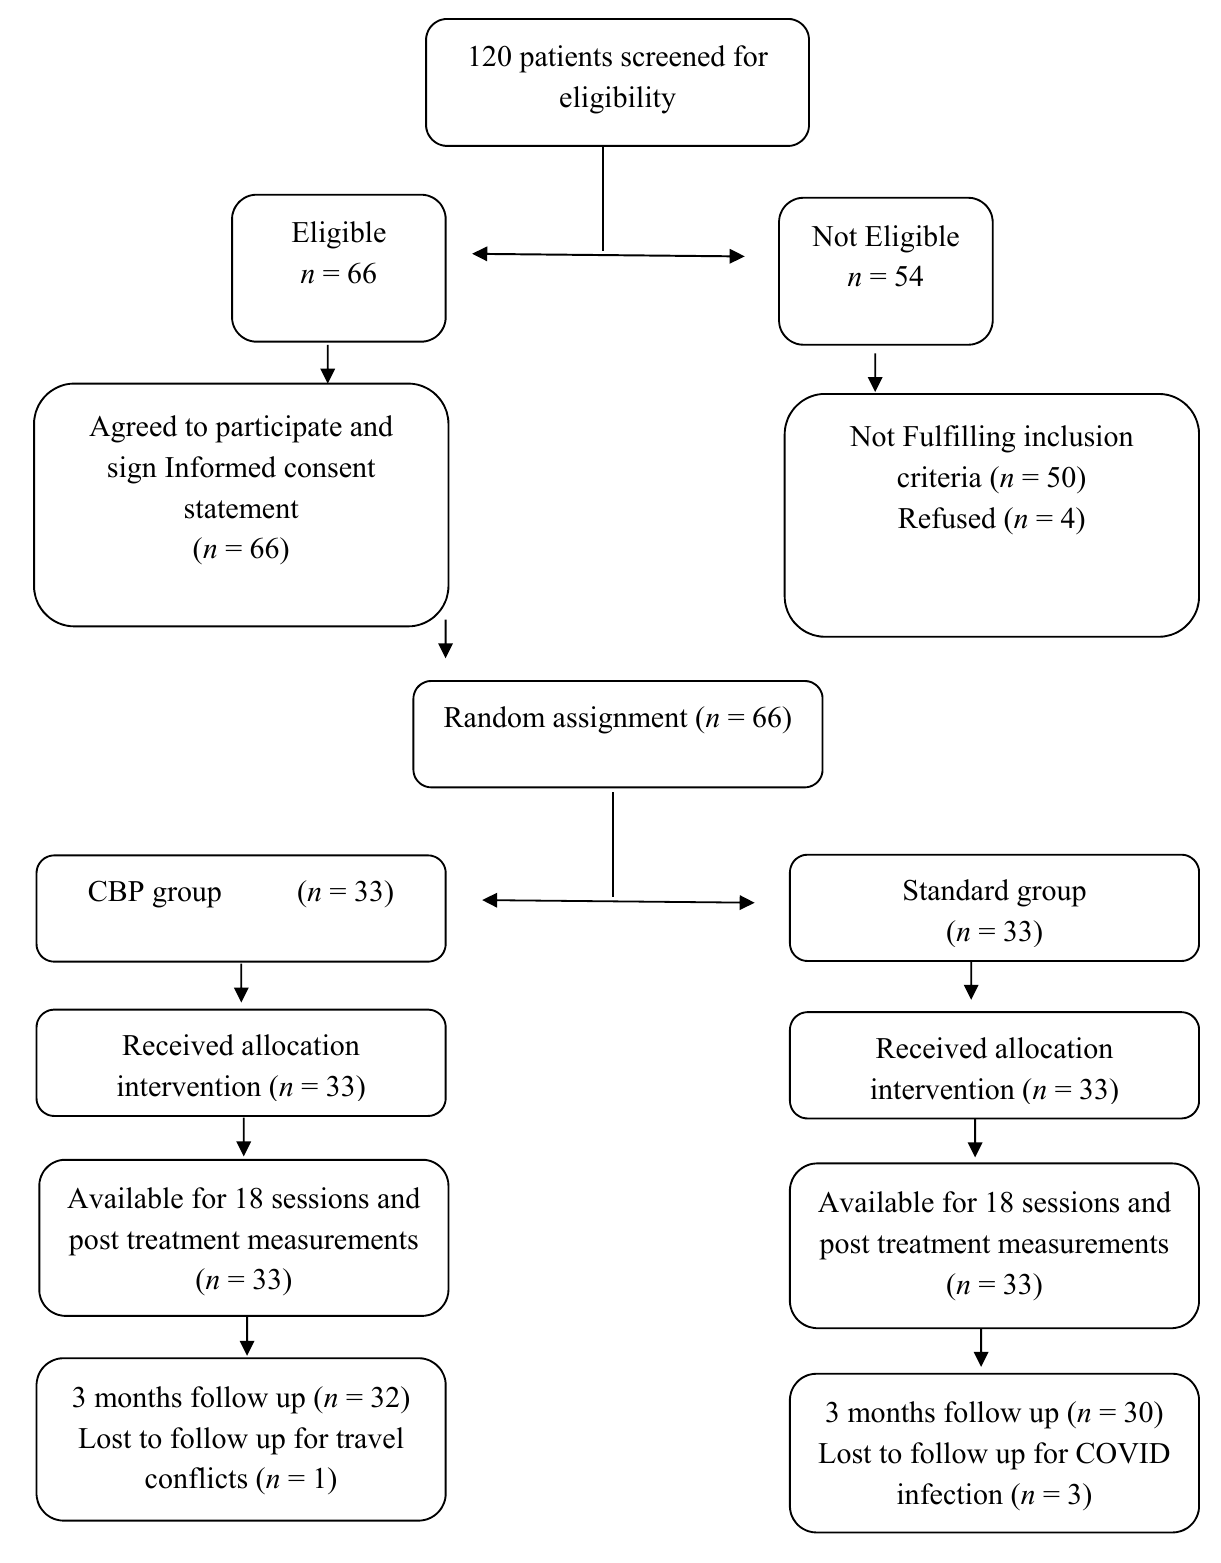
Figure 9. Flow chart of study participants. The demographic characteristics of the patients are shown in Table